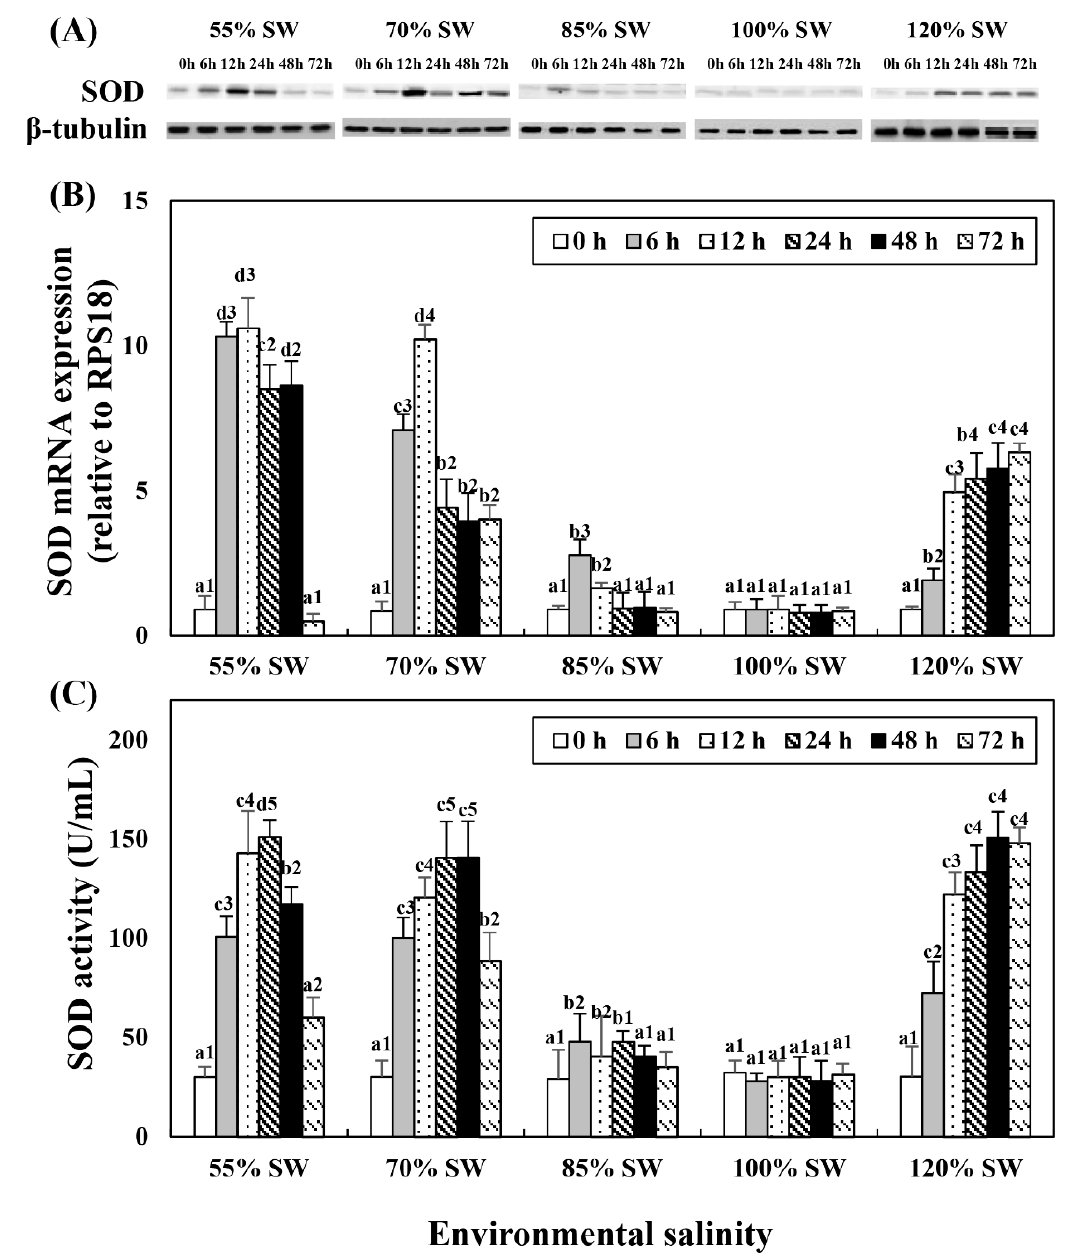
Figure 1. Changes in the expression levels of the ( A ) SOD protein and ( B ) SOD mRNA in the digestive diverticula, and ( C ) SOD activity in the hemolymph of A. irradians during a 72 h period after sudden salinity change. Different characters indicate values corresponding to different exposure times of the scallops within the same salinity concentration ( p < 0.05). Numbers indicate significant differences among salinity concentrations for the same exposure time ( p < 0.05). All values are presented as the mean ± SD ( n = 5). Abbreviations: SOD, superoxide dismutase and SD, standard deviation.